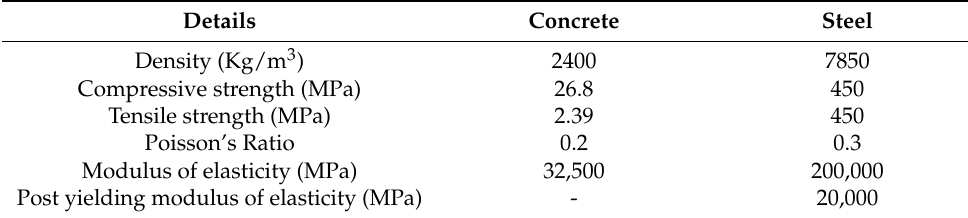
Table 1. Material information of the study culvert [39].